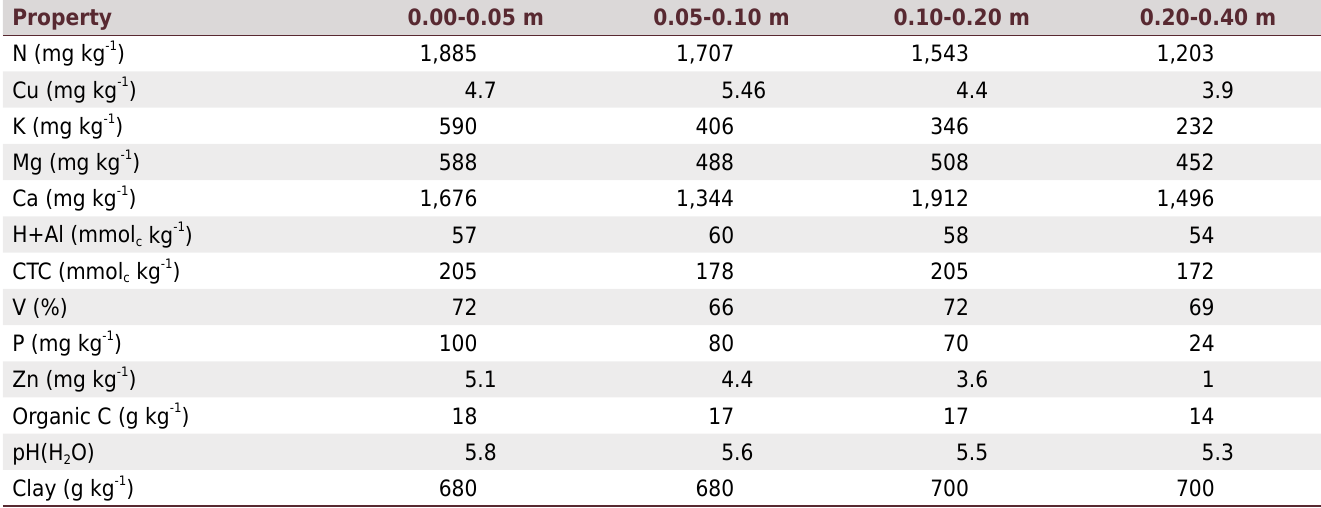
Table 1. Soil chemical and physical properties prior to fertilizer application in 2011